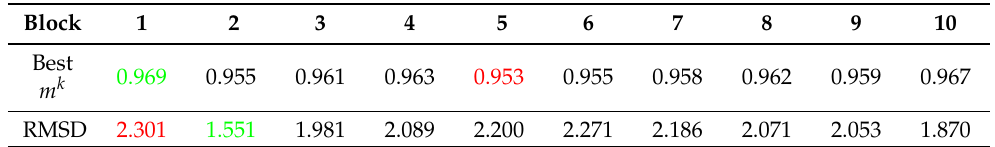
Table 1. Evolution of the solutions found at each block. Green values indicate the best solutions in terms of the average utility function m k and RMSD and the red values represent the worst ones. Block 1 2